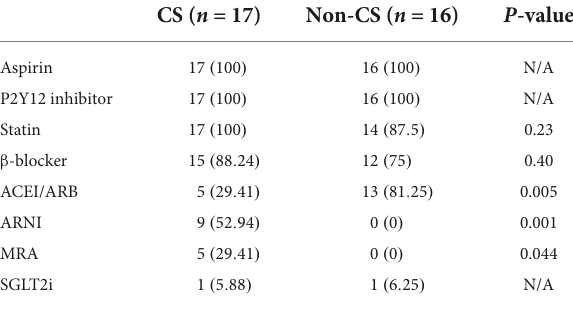
TABLE 4 Comparisons of the medical therapy between patients with- and without CS.